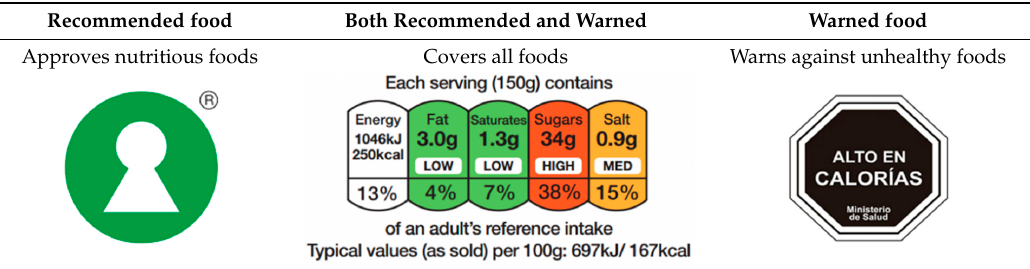
Table 2. Description and examples of FoPLs according to their Scope.